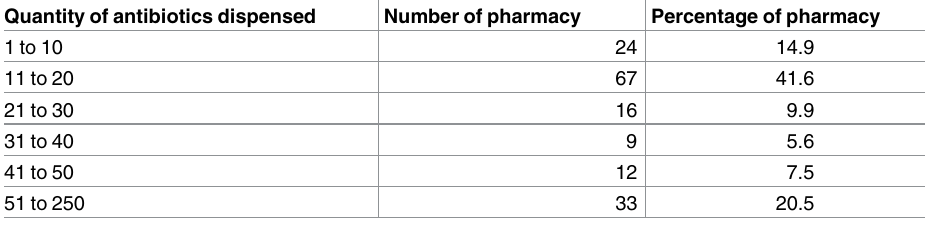
Table 3. Number of antibiotics dispensed